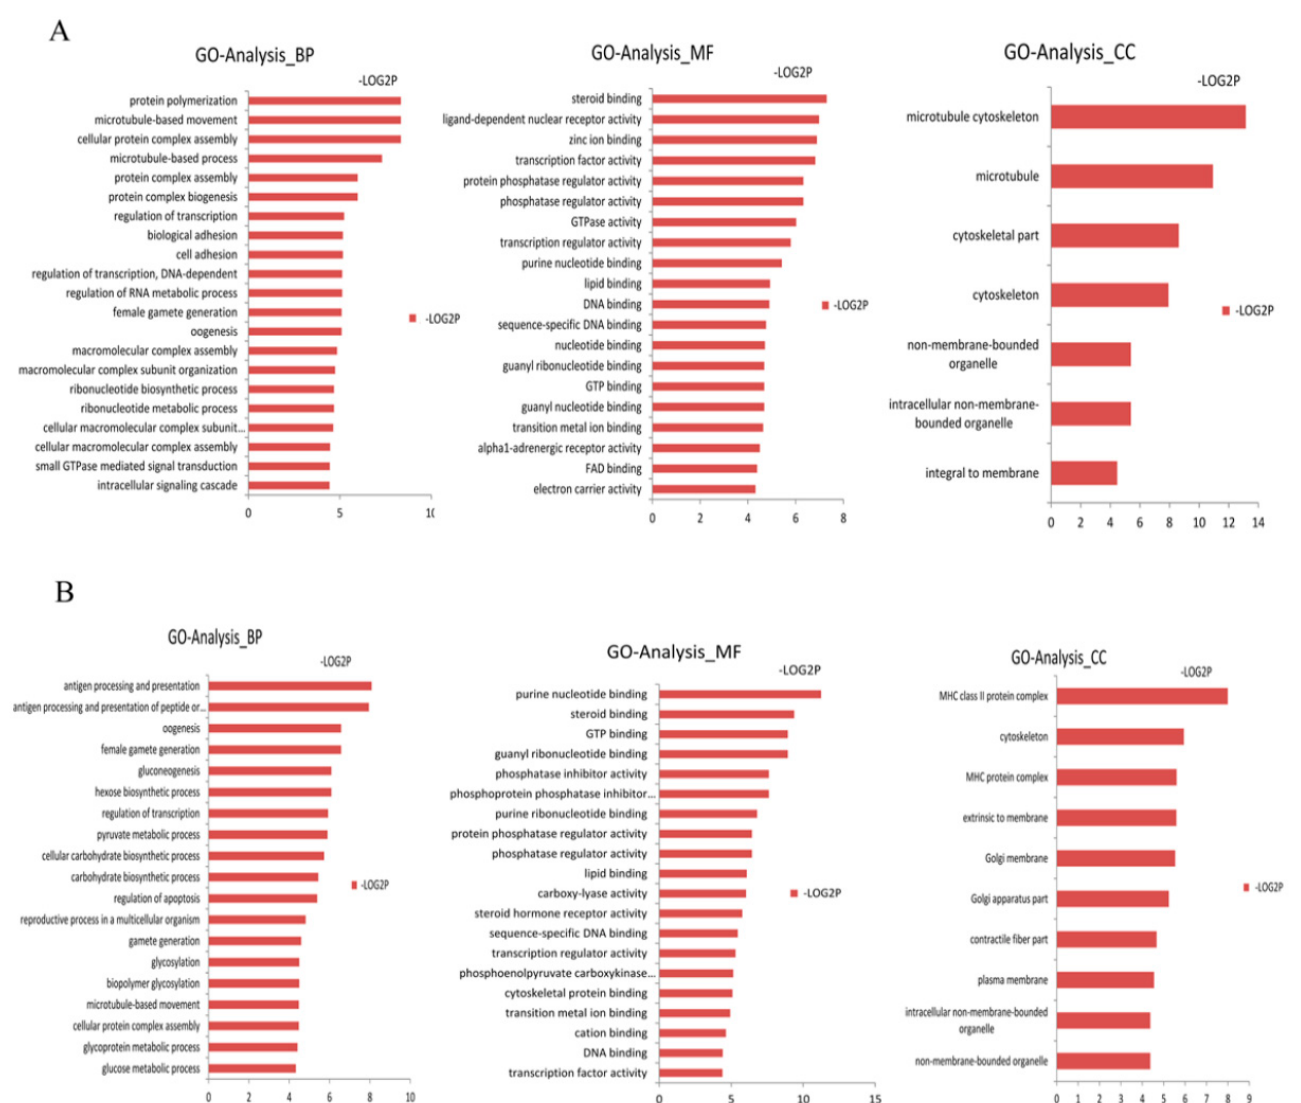
Figure 1. GO analysis of the targeted genes of the differentially expressed miRNAs. ( A ) represents the GO analysis of the targeted genes of the up-regulated differentially expressed miRNAs. ( B ) represents the GO analysis of the targeted genes of the down-regulated differentially expressed miRNAs. This figure is composed of 3 parts: biological processes (BP), molecular functions (MF) and cellular components (CC). The significance level of enrichment was p < 0.05.